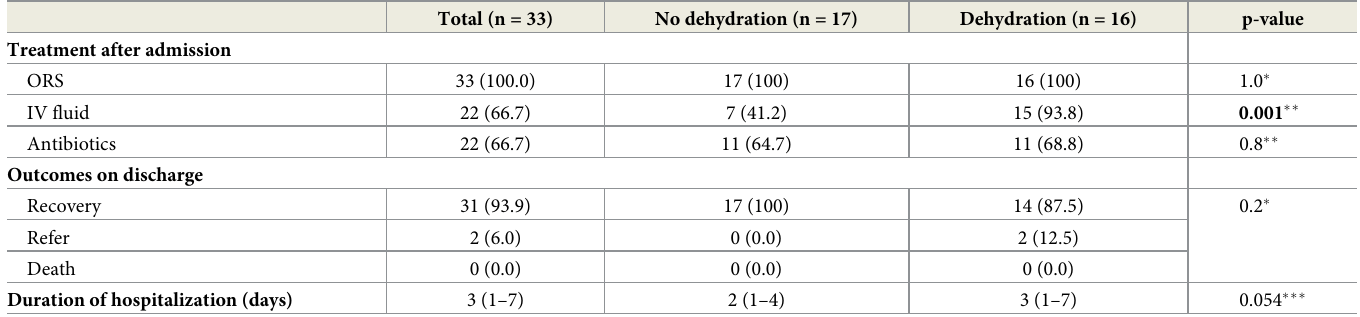
Table 3. Treatment and outcome of acute diarrhea among hospitalized U5